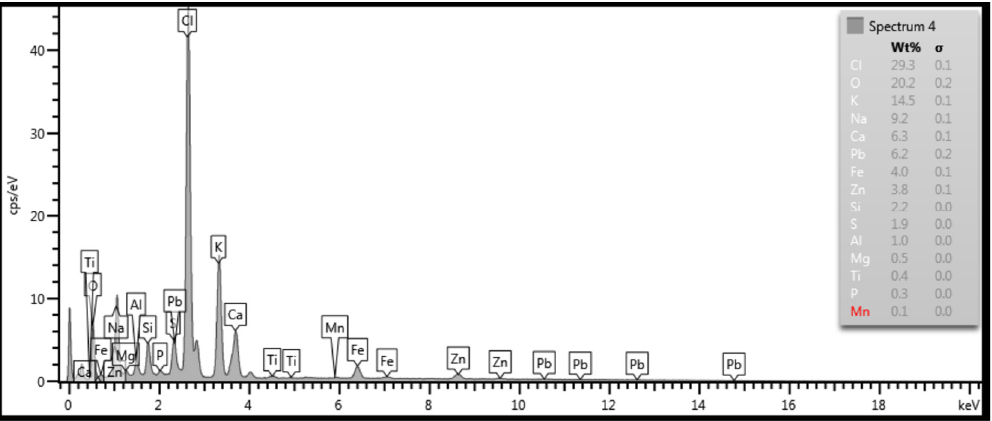
Figure 15. The outer surface of 1SEM sample with analyzed Spectrum 4 and 5 areas; SEM.